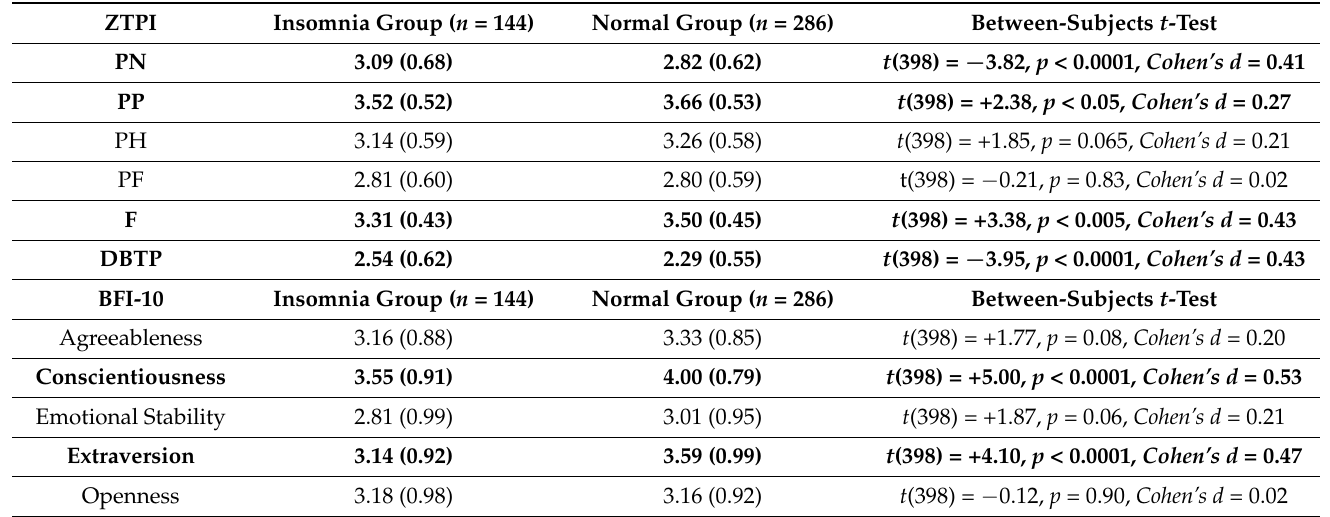
Table 1. The mean (and its SD) for every variable, separately for insomnia and normal groups. The values of t and p of all between-subjects t -test comparisons are also provided. In bold, the significant comparisons.